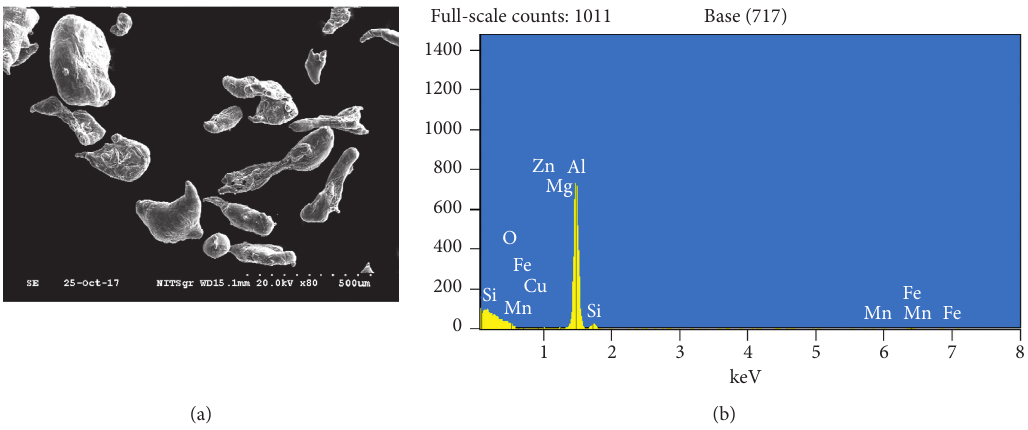
Figure 1: SEM and EDS of eutectic Al-Si alloy powder.